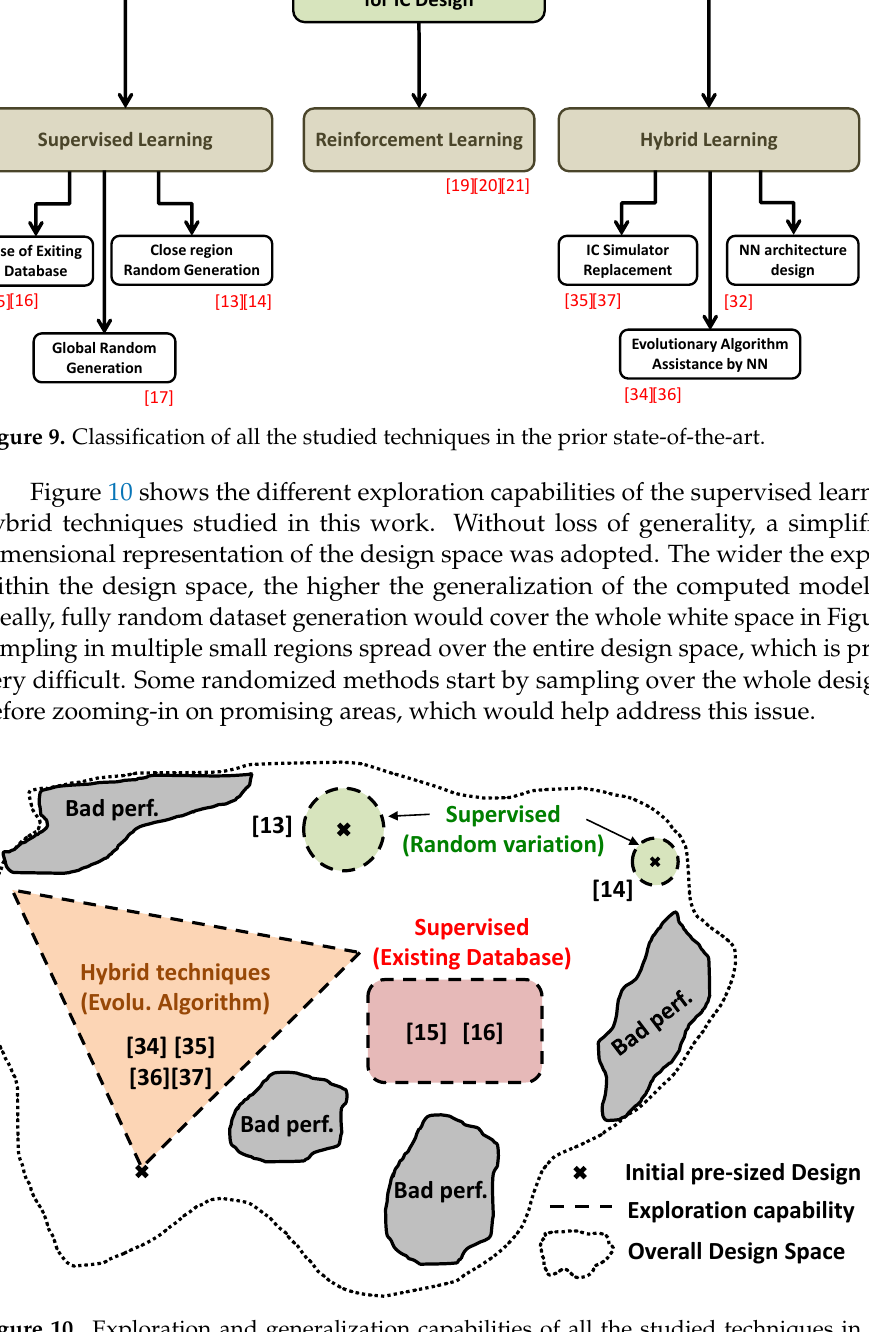
Figure 10. Exploration and generalization capabilities of all the studied techniques in the prior